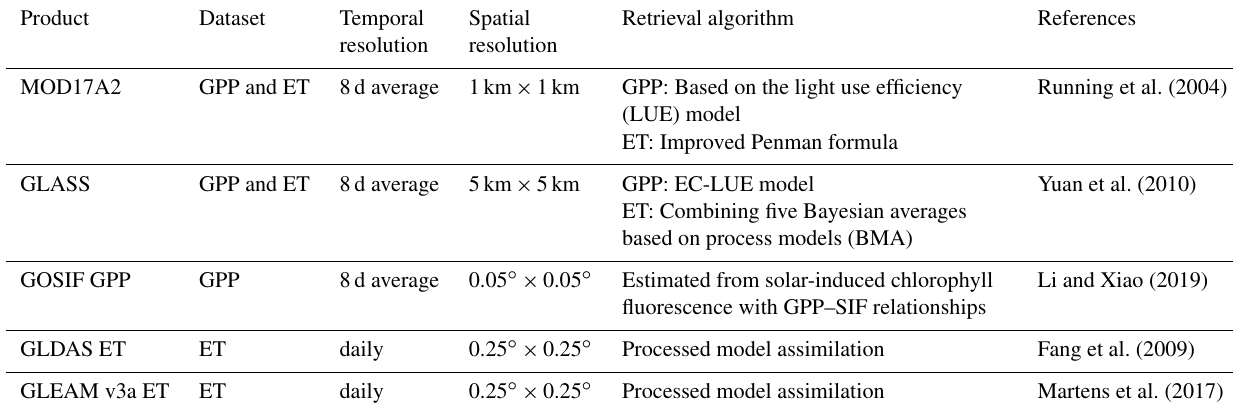
Table 3. Global GPP and ET products for comparison in this